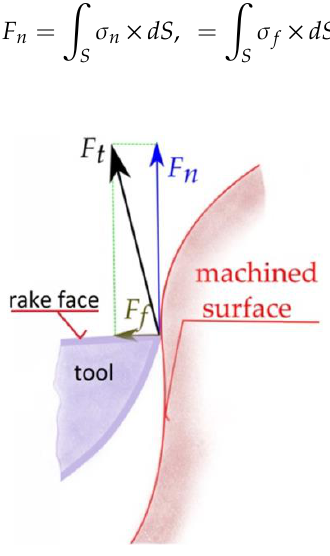
Figure 4. The scheme of the forces acting in the cutting zone.